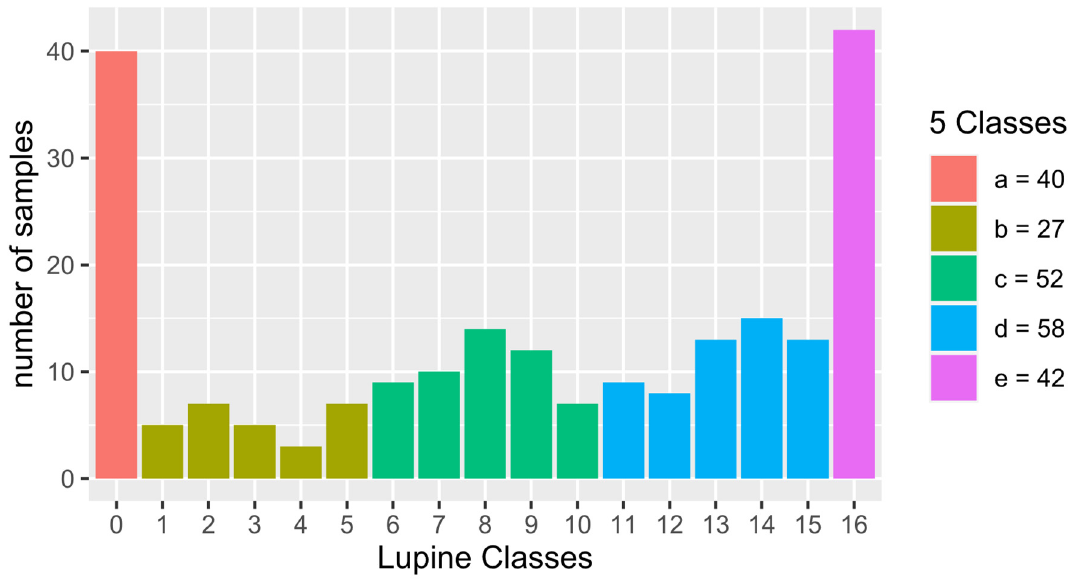
Figure A1. Number of samples for each class. 2-class scenario only used class 0 and 16, while 17 class scenario used all classes. 5 class scenario divided samples as colour coded.